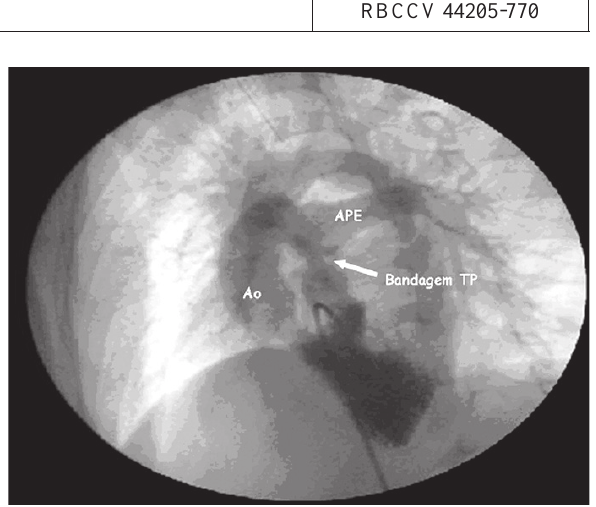
Fig. 1- Estudo cineangiocoronariográfico demonstrando bandagem adequada do tronco pulmonar (TP), aorta (Ao) anterior e artéria pulmonar esquerda (APE) desenvolvida. Nesta projeção, não